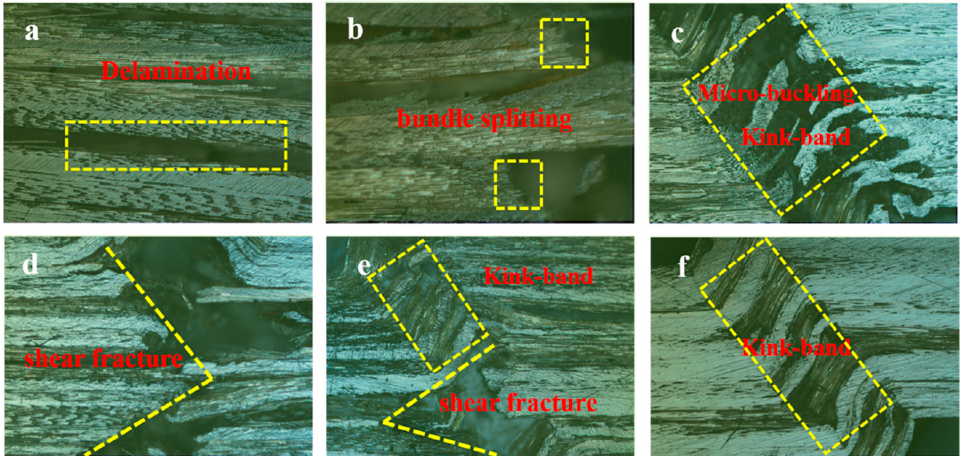
Figure 7. Optical microscope photographs of compression failure sample; ( a ) BF—Desized/PPENK, ( b ) BF-PVP/PPENK, ( c ) BF-PEN/PPENK, ( d ) BF-PPEK/PPENK, ( e ) BF-PPEN/PPENK and ( f ) BF- PPENK/PPENK composites.